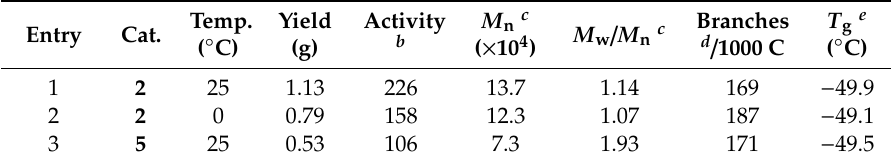
Table 3. Copolymerization of P / 1-decene with 2 - and 5 -MMAO. a .